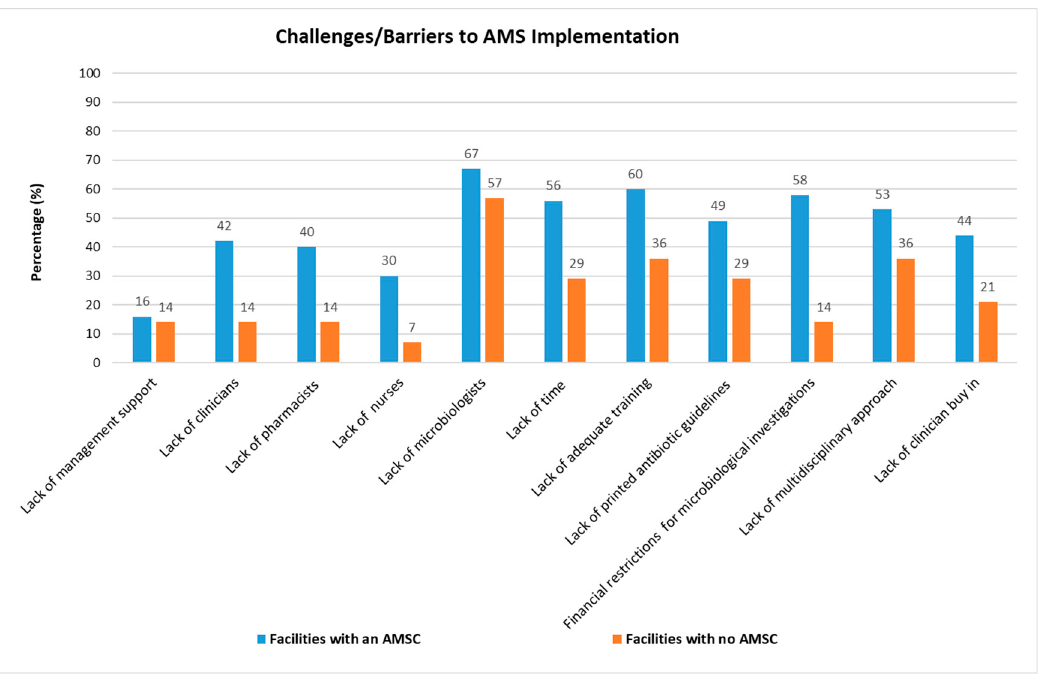
Figure 1. Comparison of challenges between facilities with an antimicrobial stewardship committee (AMSC) vs. facilities without an antimicrobial stewardship committee (AMSC). Table 7. Qualitative results recorded verbatim from survey responses outlining the challenges and barriers to implementation of antimicrobial stewardship (AMS), at facilities with or without an AMS committee, in public-sector hospitals in KZN.